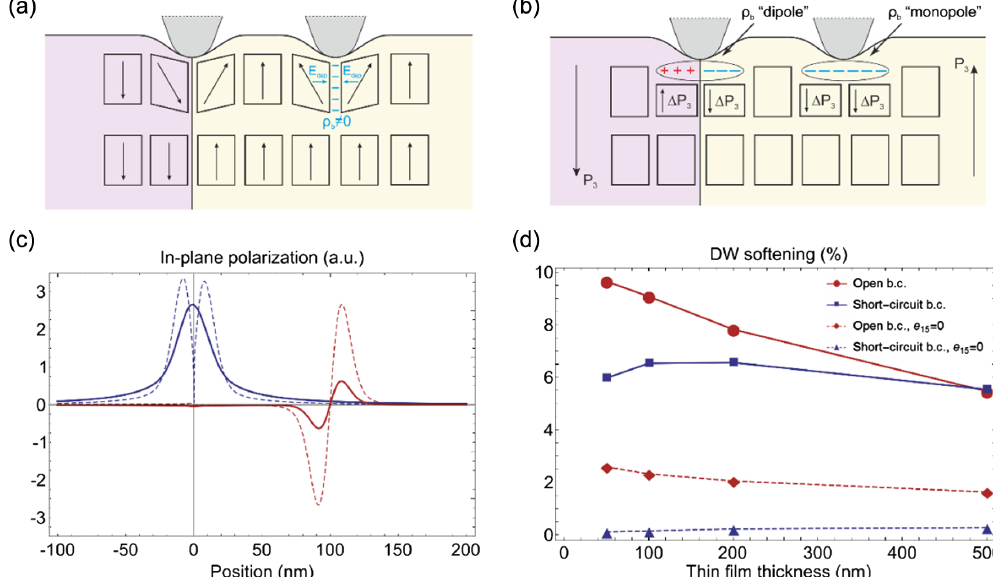
FIG. 5. (a) Schematic of the “ in-plane ” mechanism of the bound charge formation: Applying the tip to the surface induces in-plane polarization via the shear piezoelectricity: P 1 ∼ e 15 ε 5 , with larger depolarizing electric fields E when the tip is applied in the bulk dep domain. (b) Schematic of the “ out-of-plane ” mechanism of the domain wall softening: Applying the tip to the surface induces out-of- plane polarization Δ P 3 ∼ e 13 ε 1 þ e 33 ε 3 . (c) Manifestation of the depolarizing effect on the tip-induced in-plane polarization P 1 . Solid lines: Polarization extracted from finite-element modeling at a distance 5 nm from the film surface, with the tip applied at the domain wall (blue) and in the bulk domain (red). Dashed lines: Polarization expected due to the shear piezoelectric effect P 1 ≈ e 15 ε 5 , with shear strain ε 5 extracted at a distance 5 nm from the film surface. (d) Study of the domain wall softening at different electric boundary conditions, values of the shear piezoelectric coefficient e 15 , and film